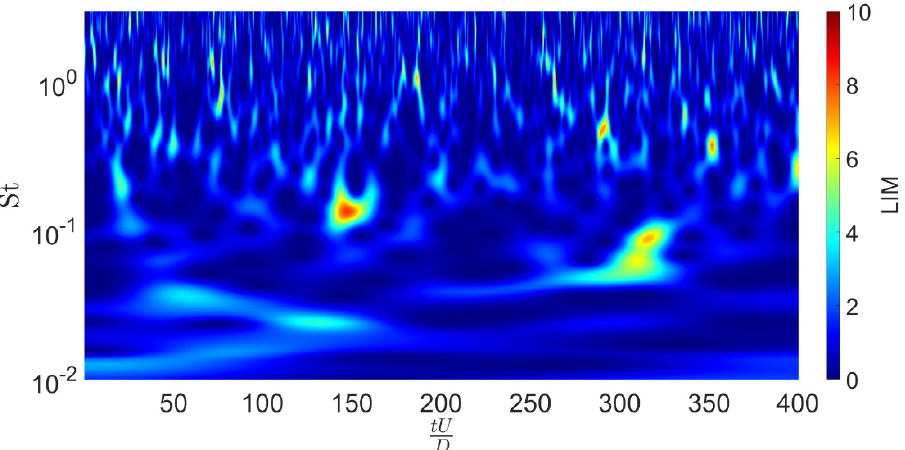
Figure 1. An example of LIM computed from a segment of a pressure signal taken at x/D = 10, r/D = 1 and M = 0.7.